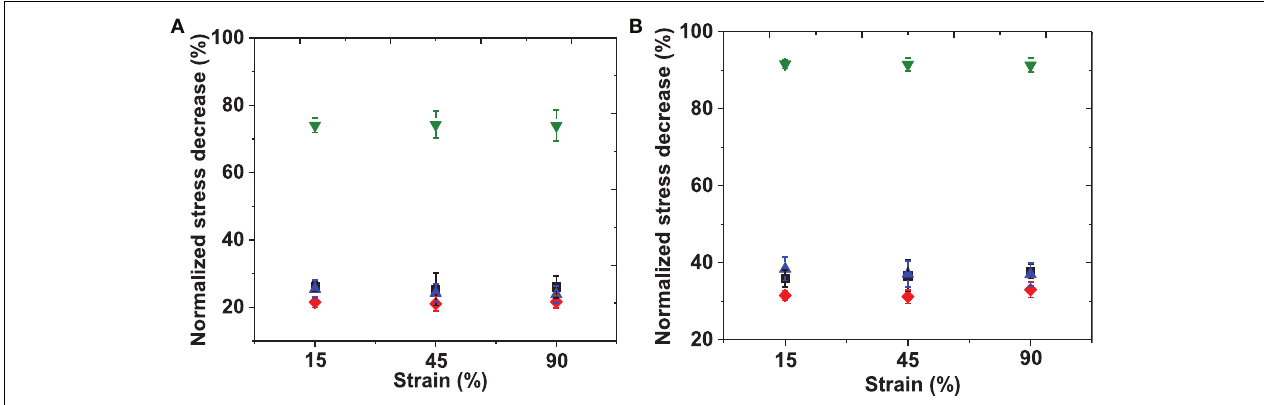
FIGURE 5 | Percentage of normalized shear stress decreased at (A) 100s and (B) 600s. Shear stresses at each strain were normalized to the shear stress at t = 0min of 5 wt% (black), 10 wt% (red), 20 wt% (blue)